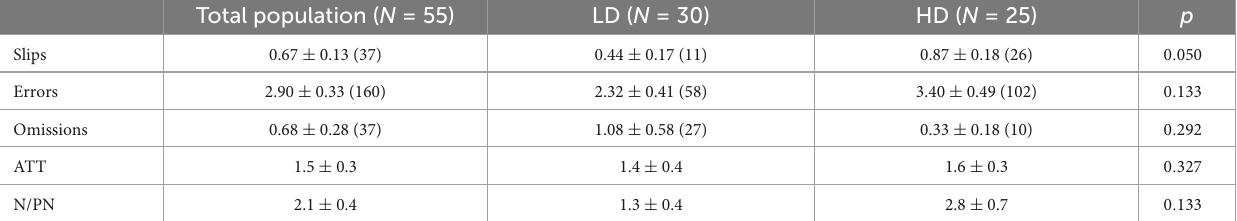
TABLE 3 Mean ± SEM for the number of slips, of verbalization errors and of omissions as well as for the number of ATT-choices in the GeoCat (on 6) and of N-choices in the PN WordList (on 20) by participant, for the lowly and highly defensive participants (LD and HD resp.); p -values for bilateral